Question: Which kind of chart has been used to present this data?
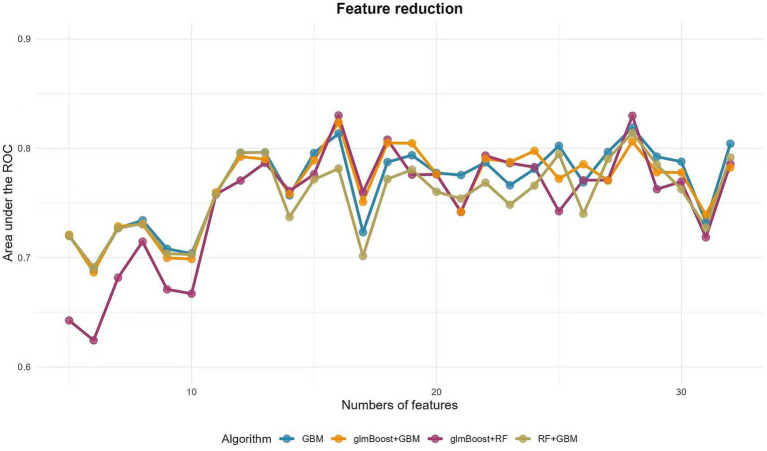
Answer: line